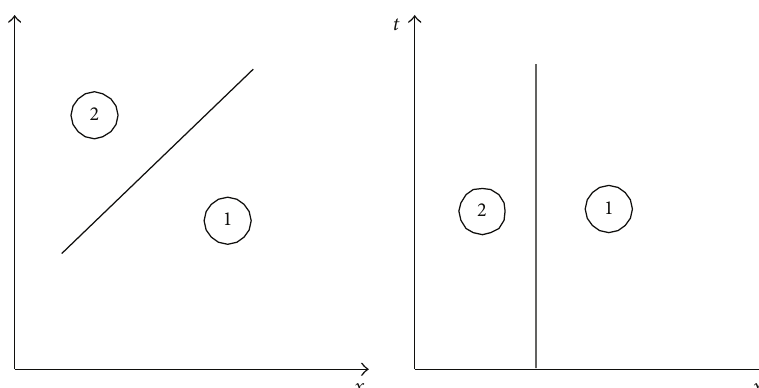
Figure 4: Schematics of moving shock wave ( 𝑊 𝑠 > 0 ). Left: global coordinates. Right: shock wave fixed coordinates.